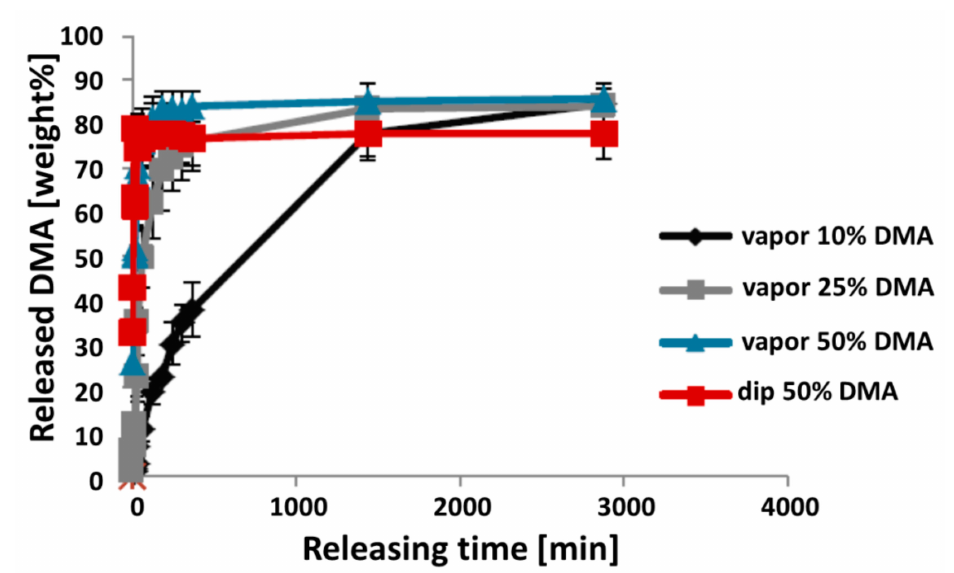
Figure 2. In vitro release of DMA from membranes, within forty-eight hours of measurement. Loading patterns are as follows: black diamond, DMA vapor exposure to 10 wt %; grey squares, vapor to 25%; blue triangle, vapor to 50%; red squares, dip-loaded to 50%. Total release of all the contained chemical into the PBS solution is referred to as 100% release. Individual values for each time point are represented as a percentage of maximal possible release or “cumulative